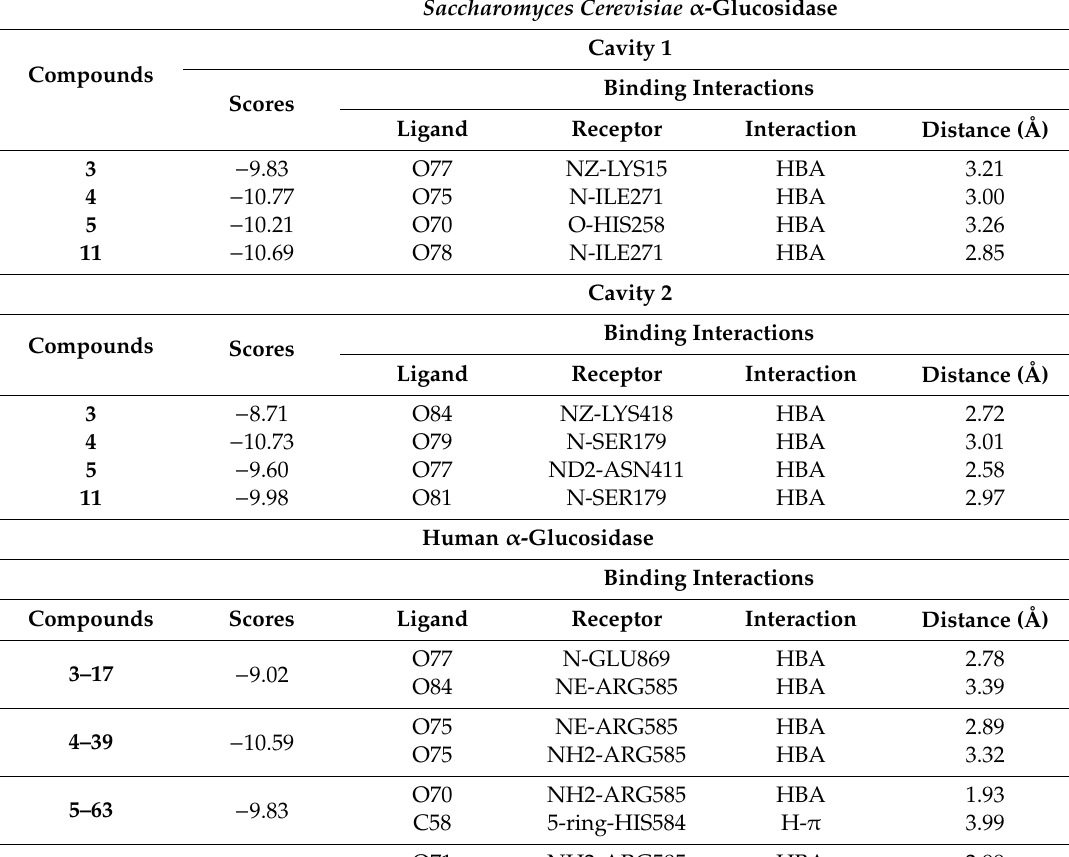
Table 3. Docking scores and binding interactions of compounds 3 – 5 and 11 at Cavities 1 and 2 of S.